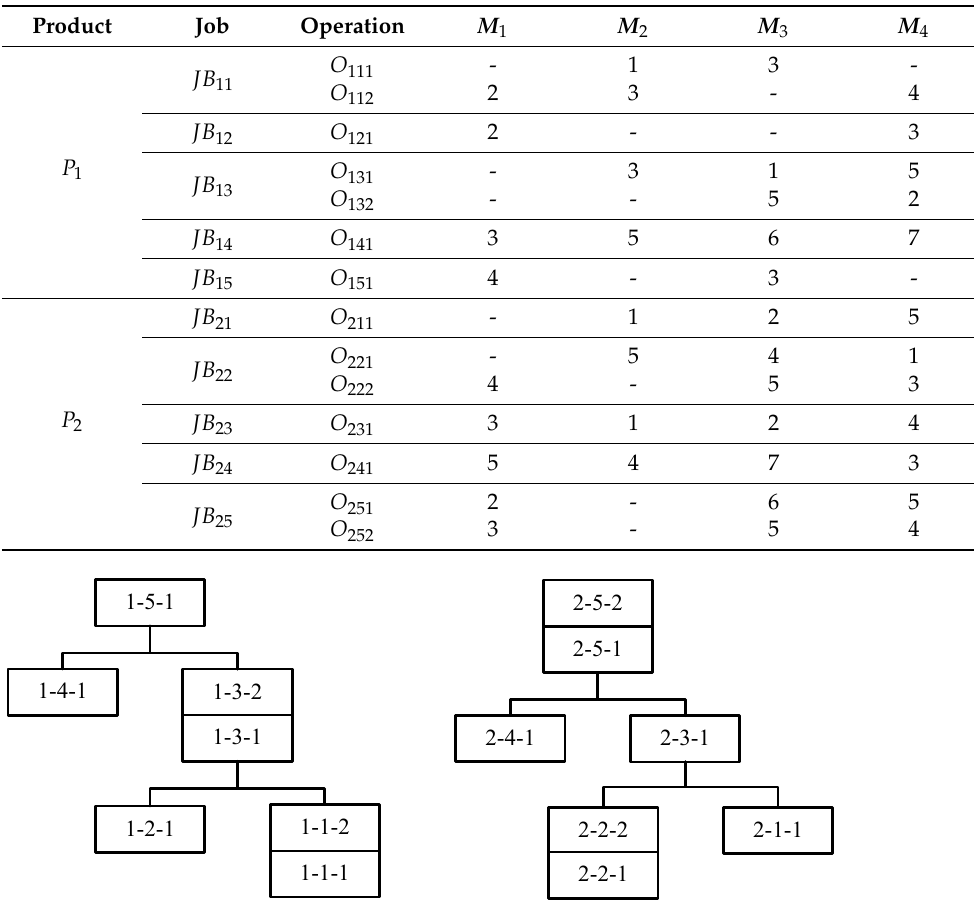
Figure 2. The encoding scheme. According to the encoding scheme, the elements in the first segment are always se- lected from the eligible machine set, which can ensure the feasibility of the machine as- signment. However, the second segment is most likely unfeasible due to the existence of hierarchical job precedence constraints. For example,